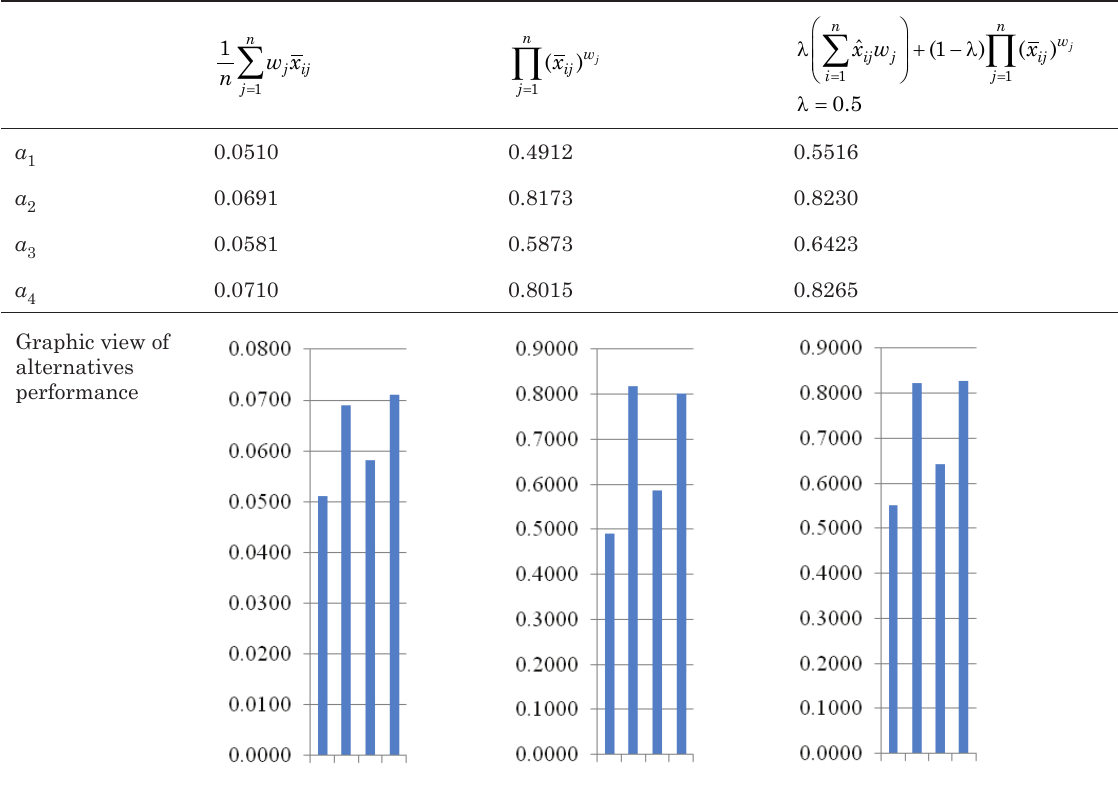
table 6. Determined optimality criteria by applying weighted aggregation of additive and multiplicative